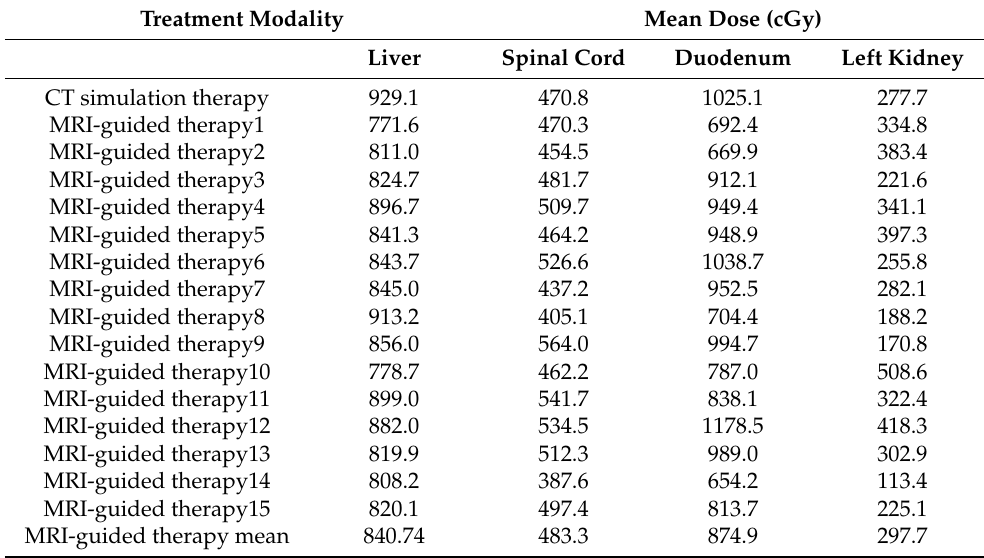
Table 1. Dose of OAR in CT simulation and MRI-guided therapy.